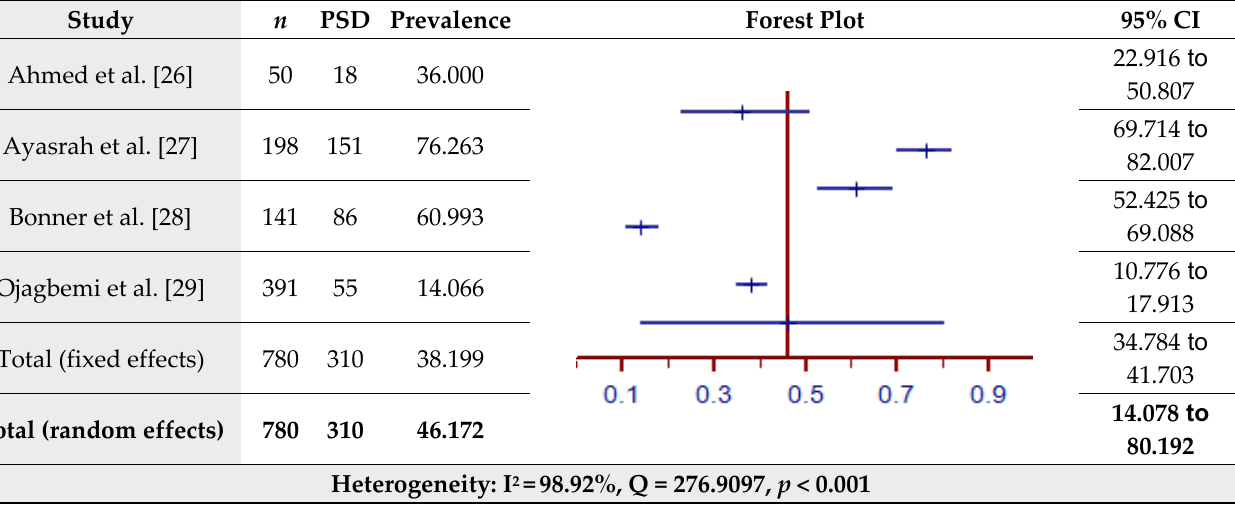
Figure 2. Prevalence estimates of Post-Stroke Depression (PSD) assessed by the Hospital Anxiety and Depression Scale (HADS).